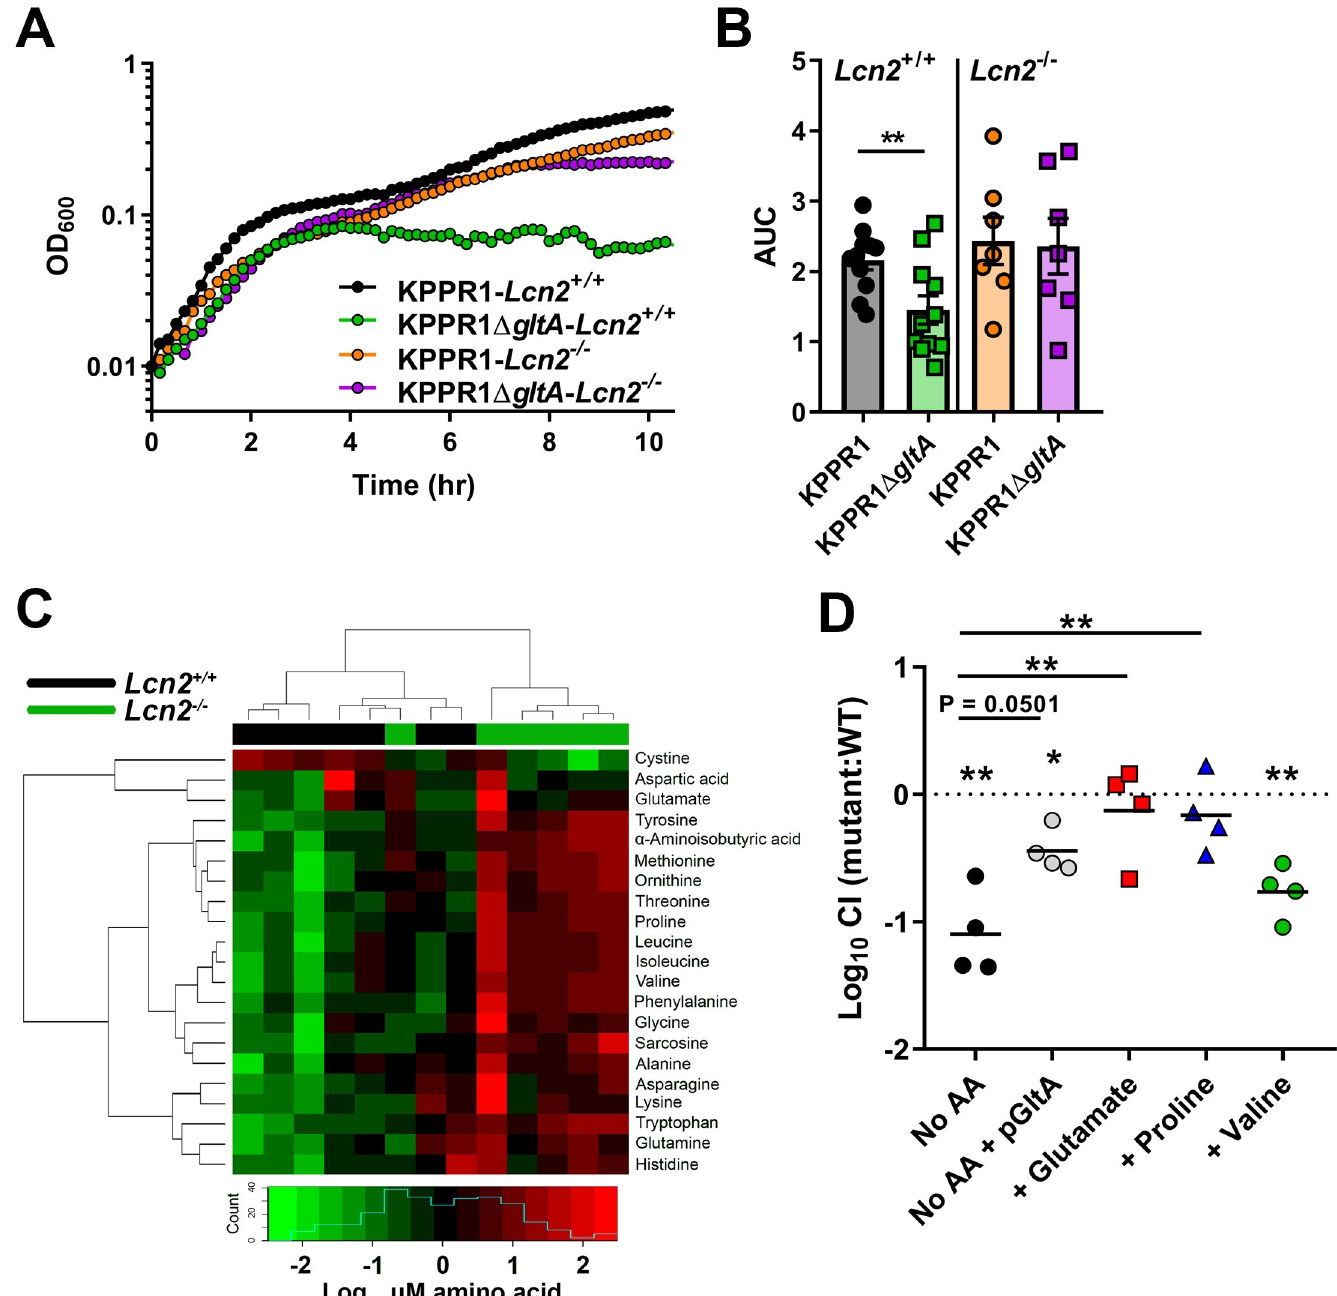
Fig 4. Bronchoalveolar lavage fluid from Lcn2 -/- mice can sustain growth of KPPR1 Δ gltA due to increased amino acid levels. (A) Murine bronchoalveolar lavage fluid (BALF) was obtained from uninfected C57BL/6J mice or isogenic Lcn2 -/- mice, and WT KPPR1 and KPPR1 Δ gltA were grown in BALF (representative curve displayed). (B) Area under curve (AUC) analysis was used to compare growth of WT KPPR1 and KPPR1 Δ gltA in Lcn2 +/+ and Lcn2 -/- BALF. (n = 7–11 per group, paired t test, mean displayed ± SEM, �� P < 0.005). (C) Heatmap of amino acid concentrations in BALF obtained from uninfected C57BL/6J mice or isogenic Lcn2 -/- mice subjected to metabolomic analysis (n = 6–7 mice per group). Blue histogram in inset indicates composite amino acid concentration values in heatmap matrix. (D) Murine bronchoalveolar lavage fluid obtained from uninfected C57BL/6J mice with or without amino acids was inoculated with a 1:1 mix of WT KPPR1 and KPPR1 Δ gltA or WT KPPR1 and KPPR1 Δ gltA pGltA. Bacterial burden was measured after 24 hours, and log 10 competitive index of the mutant strain compared to the WT strain was calculated for each sample (n = 4 per group, �� P < 0.005, ��� P < 0.0005, ���� P < 0.00005, one-sample t test or Tukey’s multiple comparison